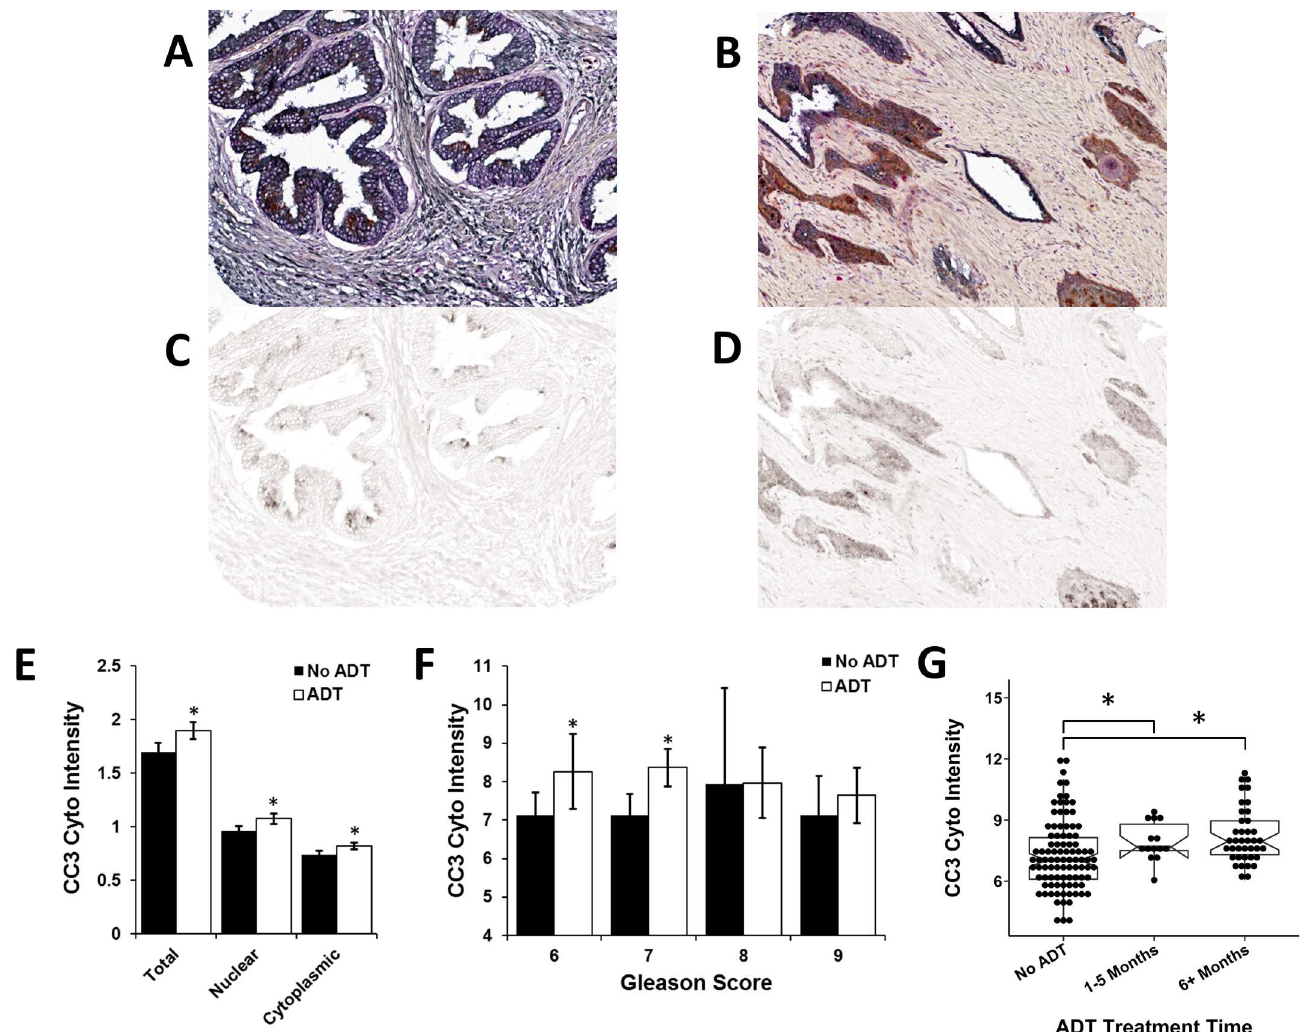
Fig 3. Cleavedcaspase3 (CC3) expressionincreasesin intermediate grade cancersand occurs early after ADT. CC3 immunohistochemistry was performed on neoadjuvant ADT and control prostate tissues and then quantitated using the automatedimaginganalyzerVECTRA. Gleason scoring was performed on pretreatment biopsies.(A) Cell nuclearand cytoplasmiclevels of CC3 demonstrate increasedexpressionin ADT treated PCa tissues and increasedlevels in Gleason score 6 and 7 (B) comparedto untreated controls. (C) CC3 expressionis shown accordingto durationof neoadjuvantADT treatment and comparedto untreatedcontrols. Significant increasesin CC3 levels were seen within 1-5mo after ADT initiation. * p < 0.05;mean ±